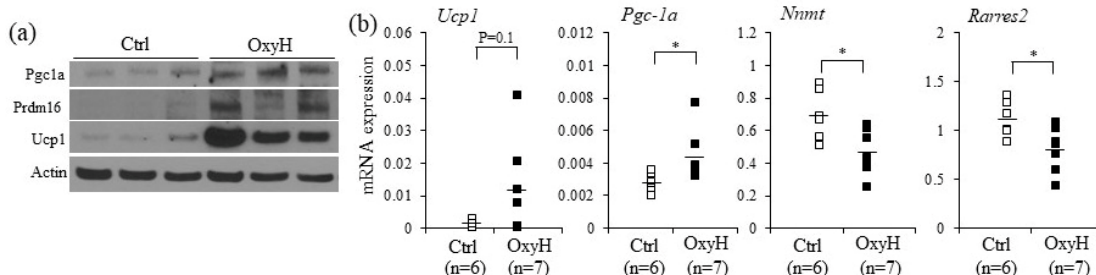
Figure 3. Oxyresveratrol selectively increases thermogenic adipocyte markers but decreases white adipocyte markers in white adipose tissues. Male C57BL/6N mice were fed a HFD and treated with vehicle control (Ctrl) or oxyresveratrol (OxyH, 15 mg/kg per day) for 8 weeks. ( a ) Expression of Pgc-1 α , Prdm16, and Ucp1 protein expression in inguinal adipose tissue from control or oxyresveratrol-treated mice was measured by Western blotting. ( b ) Expression of white selective ( Nnmt and Rarres2 ) and thermogenic selective genes ( Ucp1 and Pgc-1 α ) in epididymal white adipose tissue from control ( n = 6) or oxyresveratrol-treated mice ( n = 7) was measured by real-time PCR. Rhombus (open and closed) and bars in scatter plots represent individual mice and the average, respectively. Statistically significant differences in the control and oxyresveratrol-treated mice were determined by Student’s t -test (* p < 0.05).